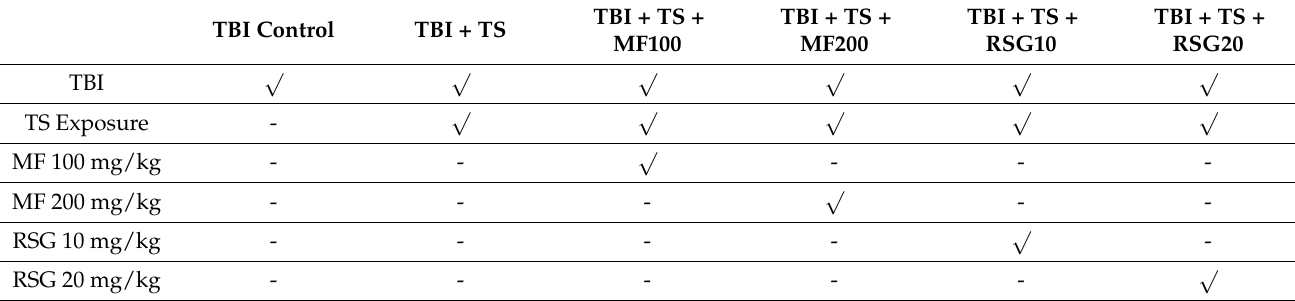
Table 1. In vivo experimental